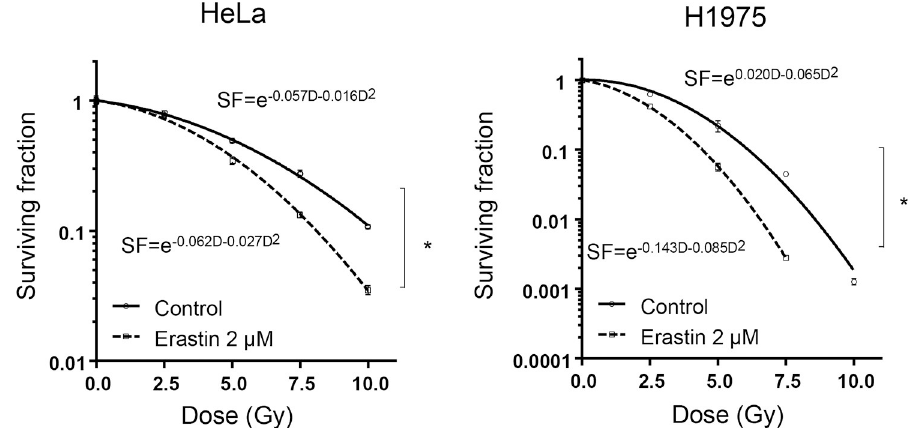
Fig 3. Erastin sensitized human adenocarcinoma cell lines to X-ray irradiation. Abbreviations: SF = Surviving fraction; D = Dose. The radiosensitizing effect of treatment with erastin was evaluated with a clonogenic survival assay of the HeLa and NCI-H1975 cells. Before X-ray irradiation, the cells were treated with 2 μ M for 24 h. The survival curves of both the cell lines were fit into a linear quadratic (LQ) model using GraphPad Prism 7. All data are expressed as mean ± S.E. (n = 3, � p < 0.0001, two-way ANOVA).